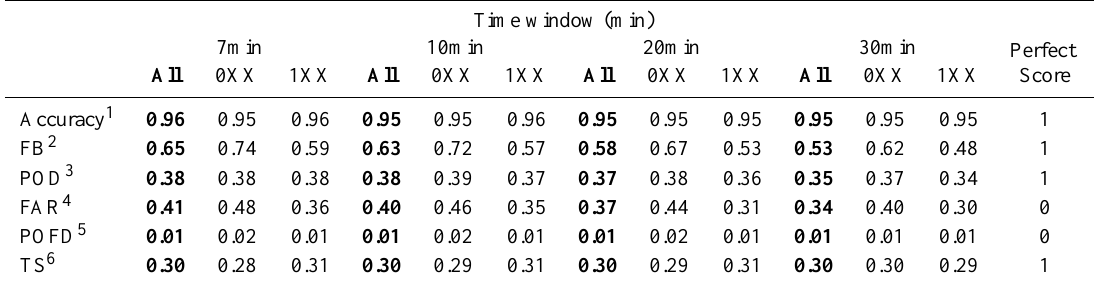
Table 2. TRMM 2A25/RG performance comparison as a function of the time scale (7-, 10-, 20-, 30-min). Definition of performance parameters is reported below.